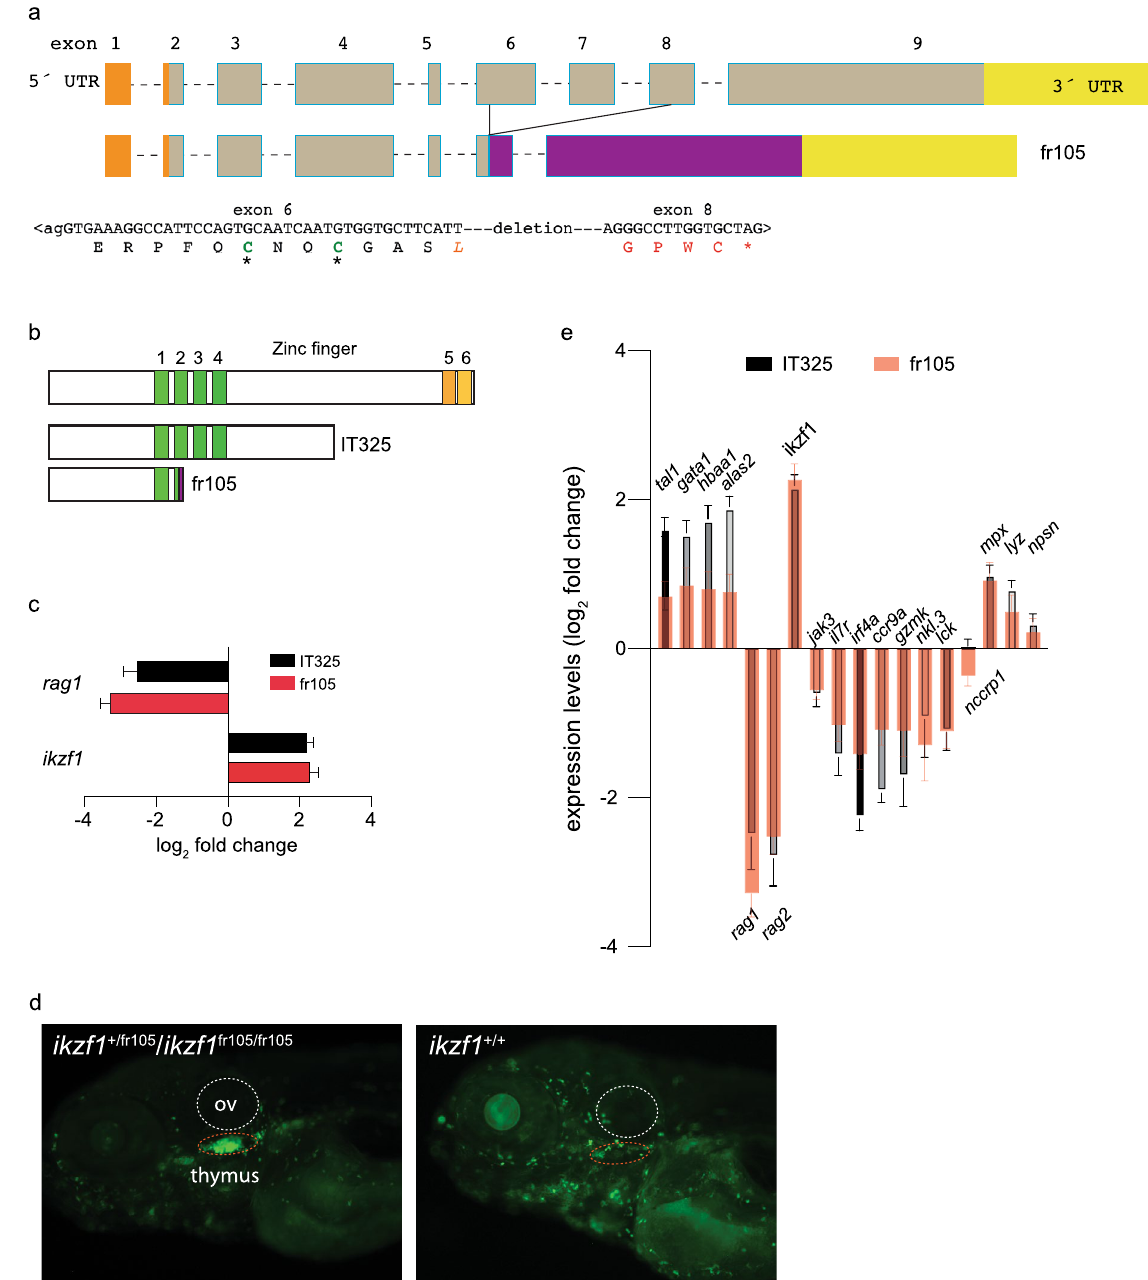
Figure 1. Characterization of a new ikzf1 allele. ( a ) Schematic structure of the zebrafish ikzf1 gene. Exons are represented by boxes and numbered and drawn to scale; the introns are indicated by dashed lines but are not drawn to scale. The 5´-UTR and 3´-UTR are indicated in orange and yellow. The CRISPR/Cas9-induced deletion in the fr105 allele is indicated; the nucleotide sequence across the junction is shown and the resulting protein sequence is given in single letter code. The deletion creates a frame-shift, resulting in the addition of unrelated amino acid residues (red letters) before a premature stop codon (*). ( b ) Schematic of the proteins encoded by the two ikzf1 alleles studied here; the IT325 allele was described by Schorpp et al. 9 . ( c ) Lack of larval T cell development in homozygous IT325 and fr105 mutants as determined by RNA-seq at 5 dpf; rag1 and ikzf1 expression levels relative to wildtype are shown (mean ± s.e.m.; n = 3 biological replicas). ( d ) Analysis of the ikzf1 fr105 allele. In the ikaros:eGFP background, wild-type and heterozygous fish cannot be phenotypically distinguished (left panel), whereas the mutants (right panel) lack fluorescent signals in the thymus (dashed red oval), and exhibit brighter fluorescence. ov, otic vesicle. e Differential gene expression patterns in IT325 and fr105 mutants at 5 dpf. The log 2 fold changes of expression levels relative to wild-type siblings are indicated (mean ± s.e.m.; n = 3 biological